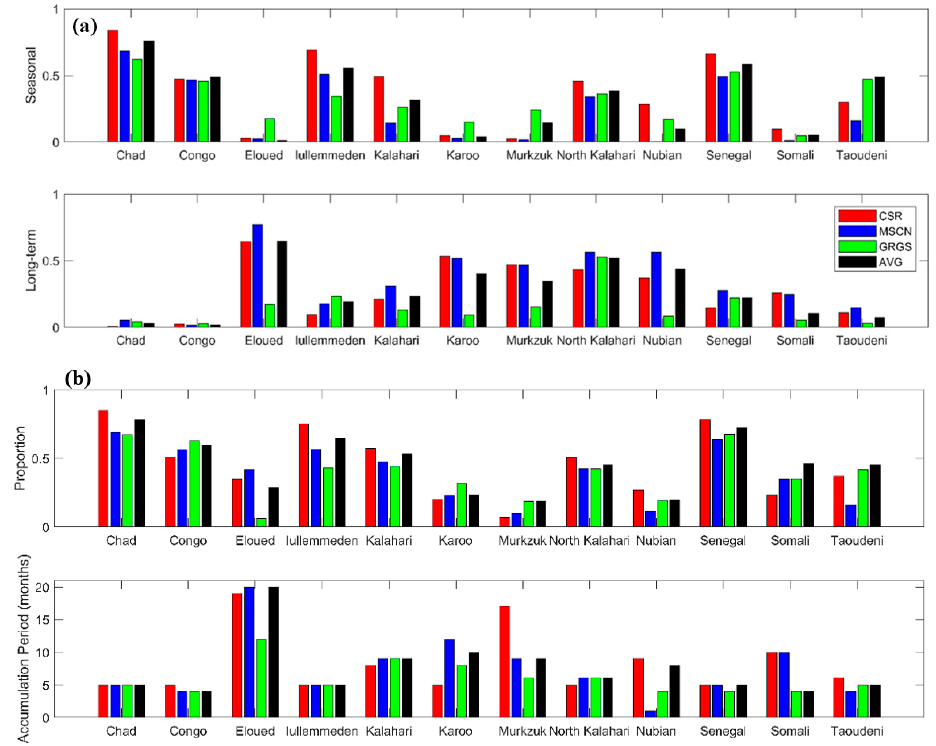
Figure 3. Plot showing: ( a ) the proportion of variance in TWS signal explained by seasonal and long term signals in each GRACE product. Ensemble is shown in black; CSR product red, MSCN product blue, and GRGS product in green; ( b ) the variance of each TWS GRACE product which is explained by rainfall, and the corresponding accumulation periods. The ensemble GRACE product is shown in black; CSR product red, JPL-MSCN product blue, and GRGS product in green.